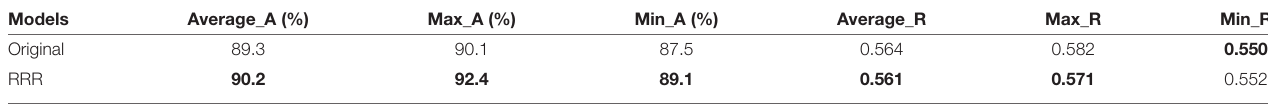
TABLE 4 | Accuracy and explanation assessment (RMSE) results for the five-fold cross-validation.